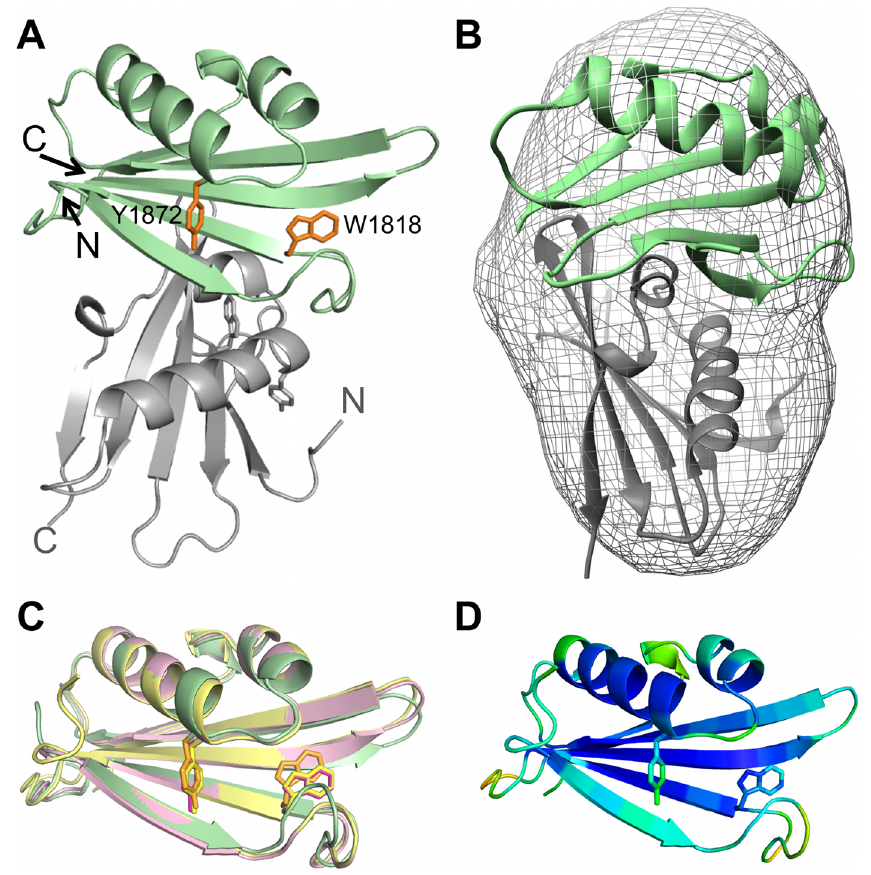
Fig 5. Atomic structure of isolated CASV L-Cterm domain 2. A) Ribbondiagram of CASV L-Cterm domain2 structure. Chain A is shownin palegreen, chain B in grey. The N- and C-terminiare marked and potential cap-bindingaromatic sidechains Y1872 and W1818 are shownas sticks and coloredin orange. B) Superimposition of SAXS derived molecularshape of L-Cterm at a concentration of 4.5 mg/ml and ribbon diagramof crystal structure. C) Superimposition of ribbondiagramsof chain A and B from isolated CASV L-Cterm domain2 crystal structure (magenta and yellow, respectively) and L-Cterm crystal structure (green). Potential cap-binding aromatic sidechainsare highlightedwith saturate colors. D) Representation of chain B of L-Cterm domain2 colored by B-factor with the highest observedB being 106 (orange)and the lowest 22 (dark